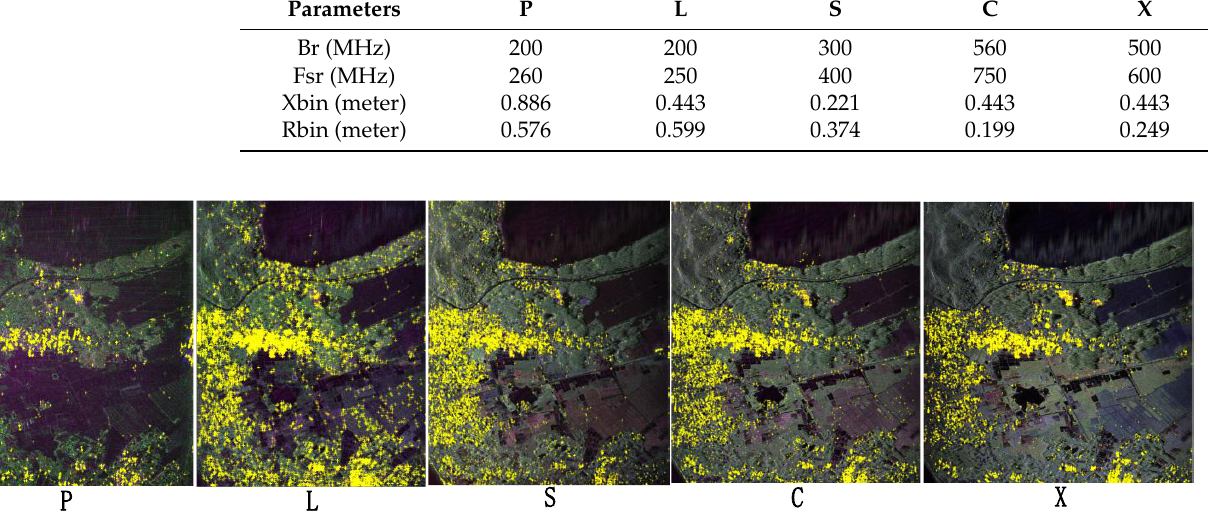
Figure 9. The RDB targets extracted from airborne data of different bands in the same scene. The corresponding P/L/S/C/X band information is given at the bottom of each figure. The Pauli pseudo- color map is shown in the figure, and the RDB targets extracted from the scene are shown as yellow markers on each band image.